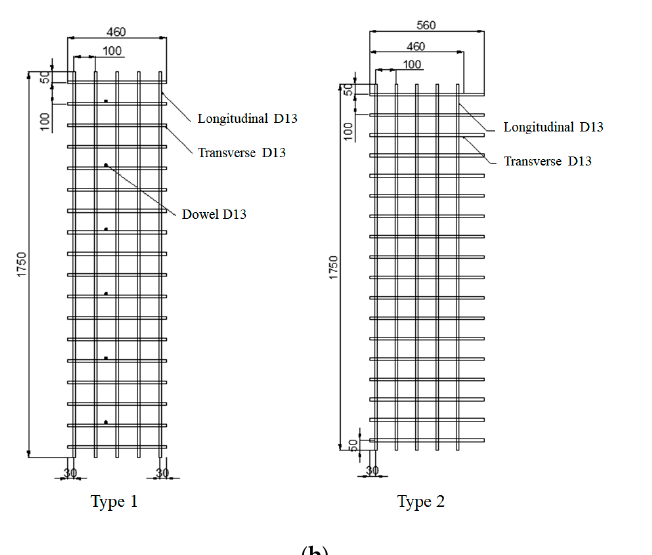
Figure 2. Details of the specimens (mm): ( a ) Sections of columns and footings; ( b ) the SGR of Type 1 and 2.